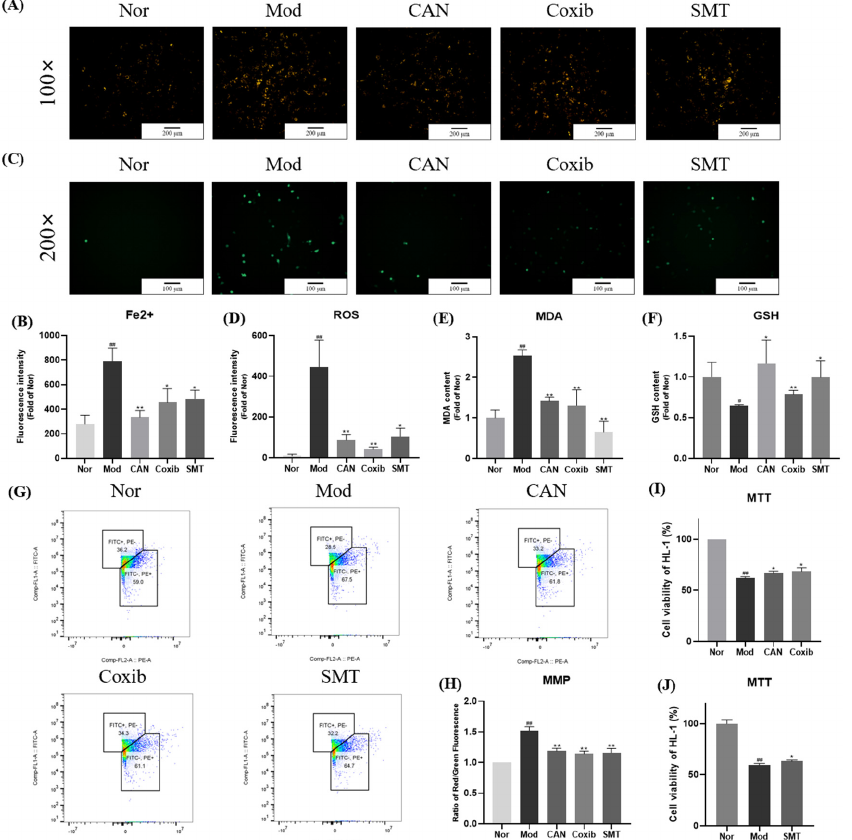
Figure 4. Canagliflozin regulates ferroptosis indexes in PA-treated HL-1 cells through inflammatory inhibition. HL-1 cells were stimulated with 0.1 mM PA for 24 h in the presence or absence of CAN (5 μ g/mL), and the whole cell lysates from HL-1 cells were used for Western blotting analysis. Coxib (5 μ g/mL) and SMT (10 μ M) were used to explore the relationship between ferroptosis and inflammatory damage. ( A ) Representative images of intracellular Fe 2+ in HL-1 cells stained with FeRhoNox-1. ( B ) Quantification analysis of intracellular Fe 2+ . ( C ) Representative images of intracellular ROS in HL-1 cells stained with DCFH-DA. ( D ) Quantification analysis of intracellular ROS. ( E ) Intracellular MDA was assessed by MDA kit. ( F ) Intracellular GSH was assessed by GSH kit. ( G , H ) Quantification analysis of mitochondrial membrane potential in HL-1 cells by flow cytometry. ( I , J ) Effects of CAN, coxib, and SMT on cell viability of HL-1 cells, which were analyzed by MTT assay. Nor, normal control group; Mod, untreated PA control group; CAN, CAN-treated PA group; Coxib, coxib-treated PA group; SMT, SMT-treated PA group. Data were expressed as mean ± SD ( n = 3). Differences were considered significant at p < 0.05 and highly significant at p < 0.01 (# p < 0.05, ## p < 0.01 vs. Nor; * p < 0.05, ** p < 0.01 vs. Mod).